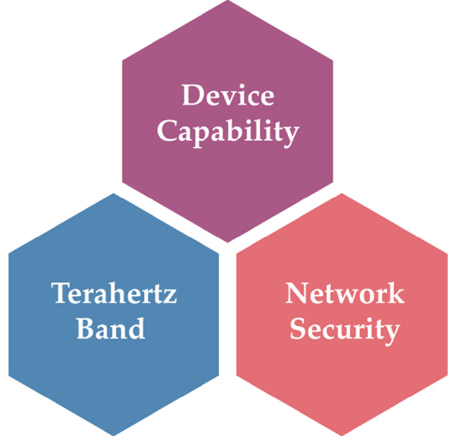
Figure 10. 6G prominent